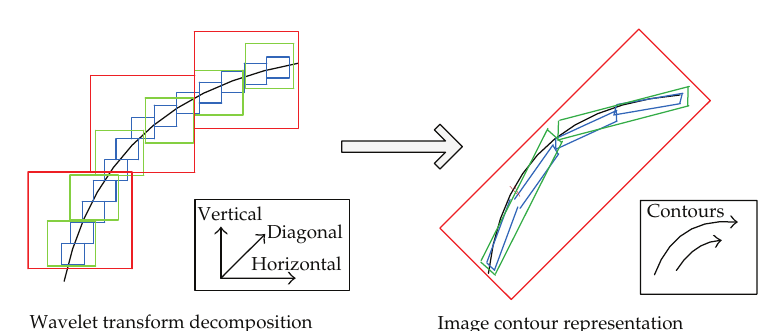
Figure 1: Multidimensional image